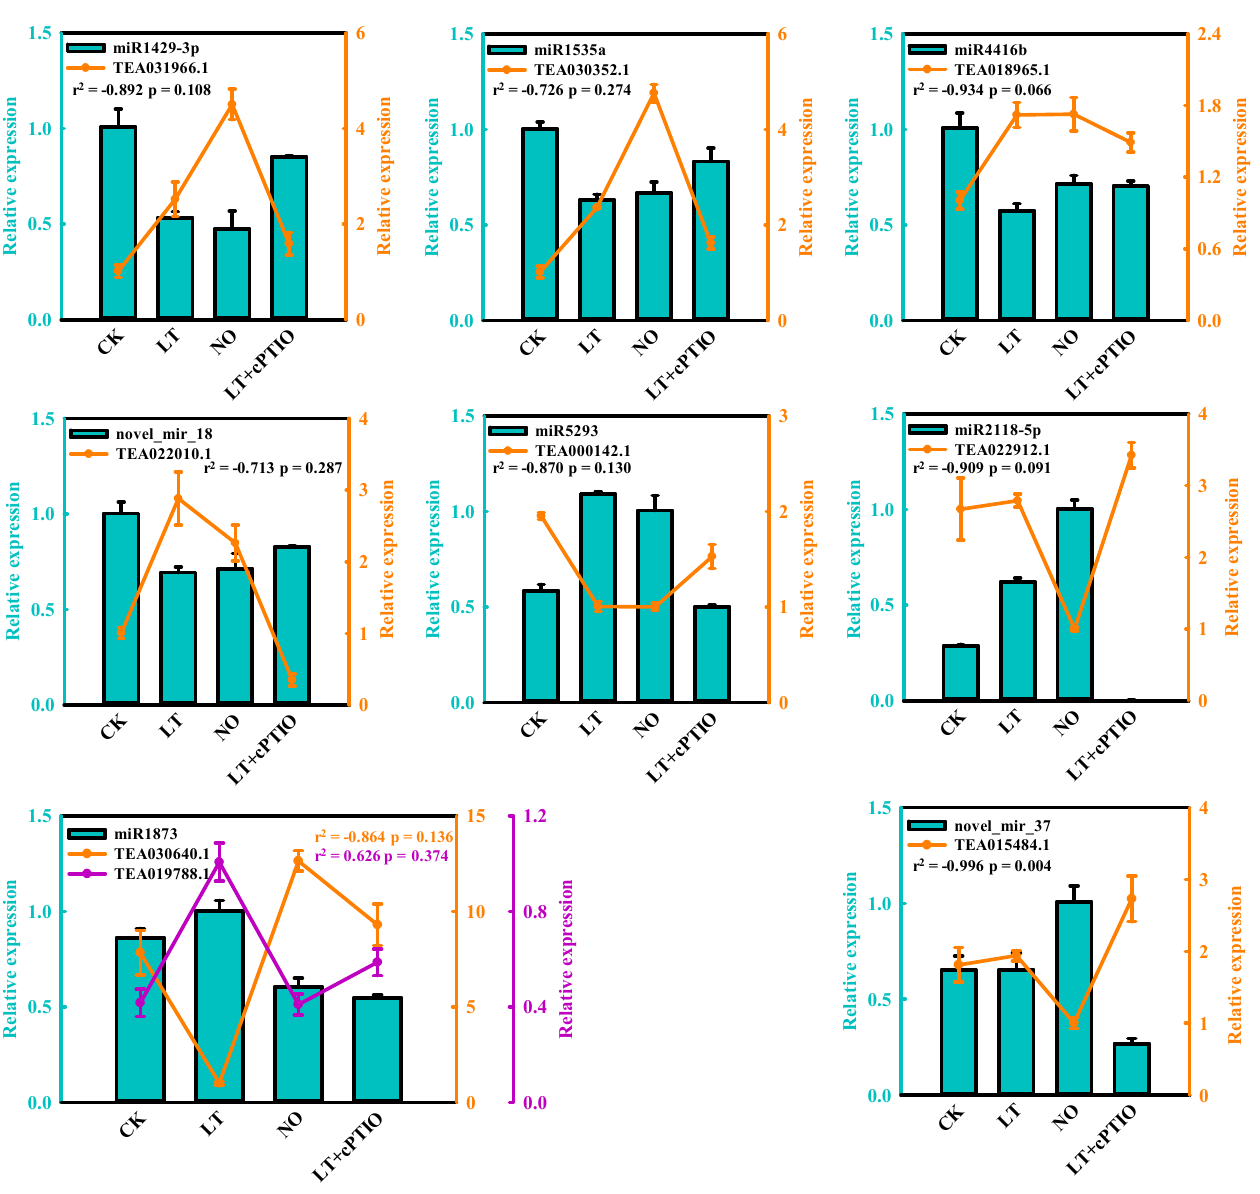
Figure 9. Expression validation of selected microRNAs (DEMs) and the target genes in CK (control), LT (low-temperature) and NO (nitric oxide) by RT-qPCR. The error bars show standard deviation between biological replicates. r 2 represents the Pearson’s correlation factor.